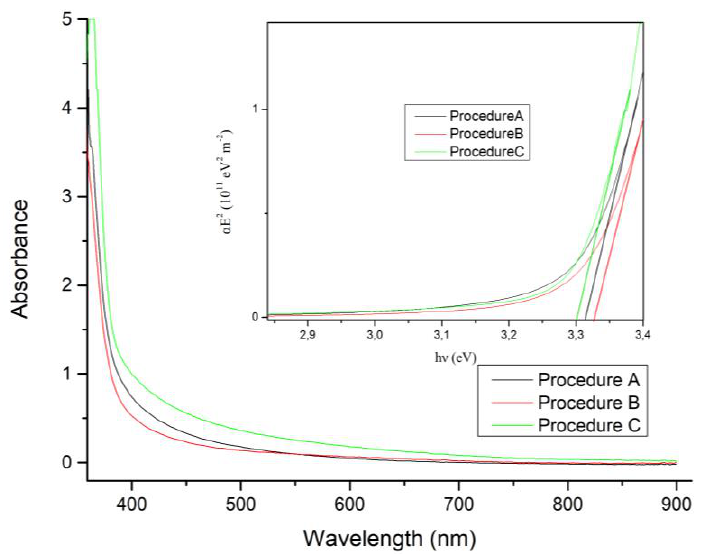
Figure 5. UV-vis transmittance spectra of the ZnO nanorods grown in 0.5% formamide for each of the three procedures A, B and C. Inset: (αE) 2 versus E—where E is the photon energy and α is the absorption coefficient.